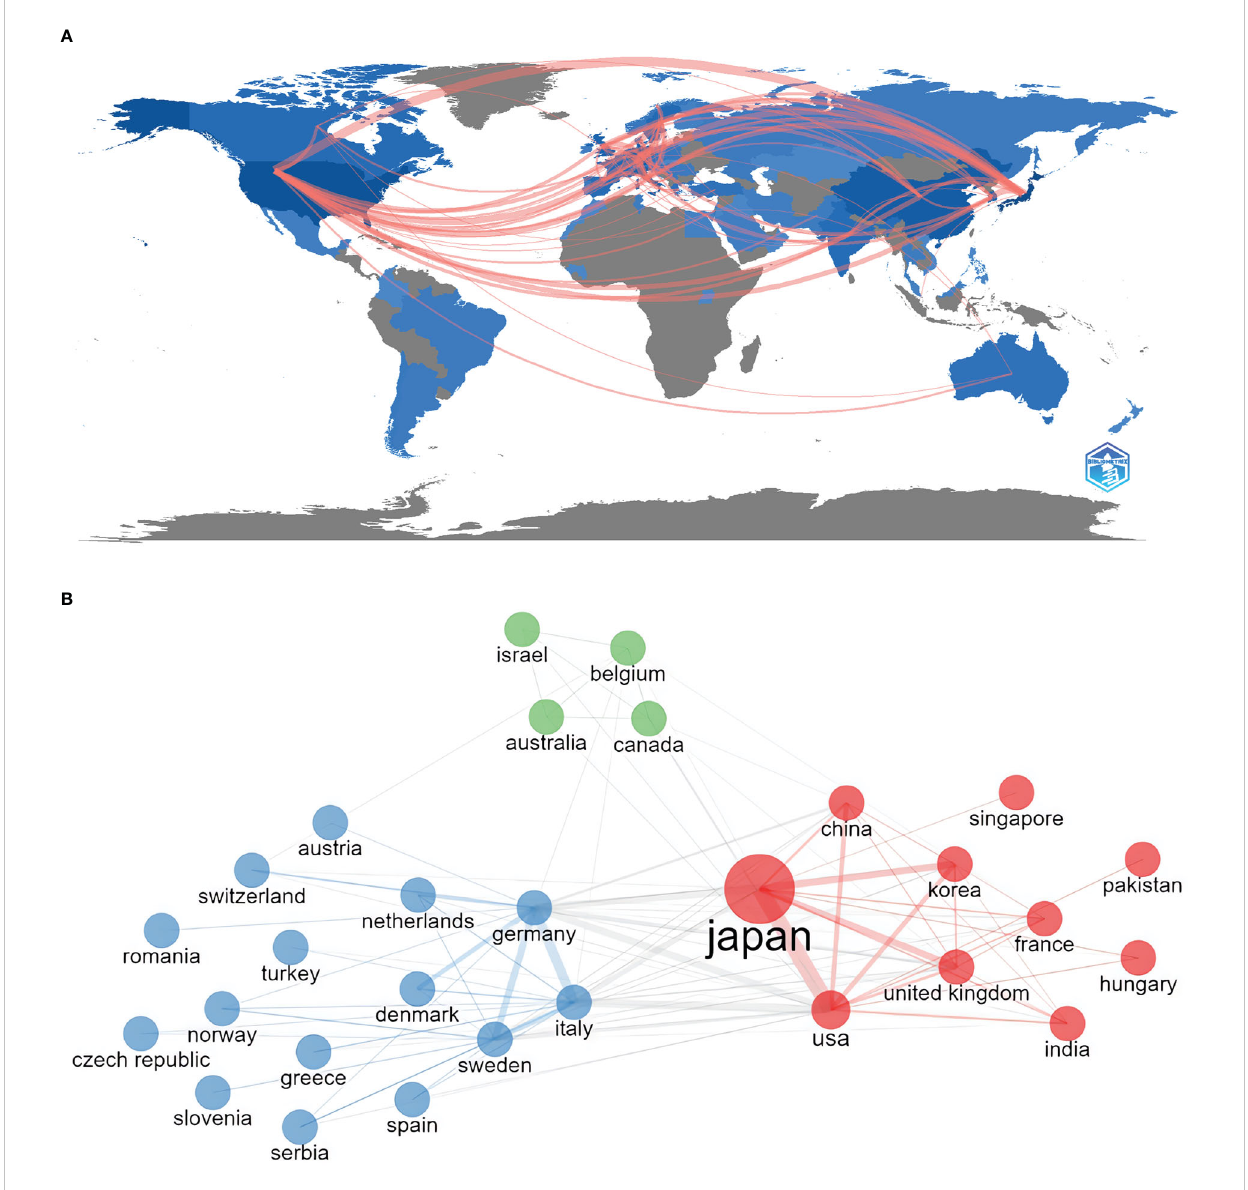
FIGURE 3 Leading Countries/Regions. (A) Distribution of publications and collaborations between countries/regions and (B) clustering of collaboration among